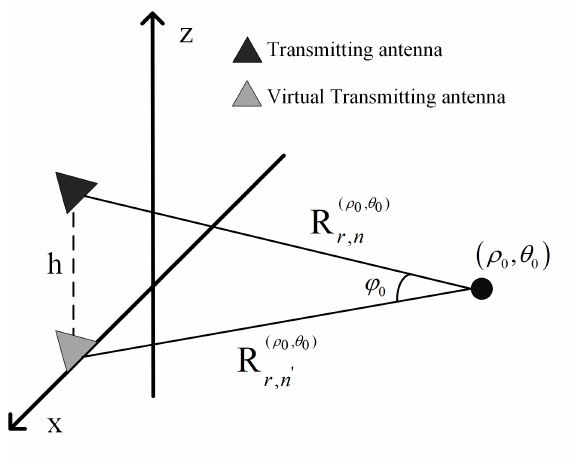
Figure 7. Schematic diagram of transmitting unit and virtual transmitting